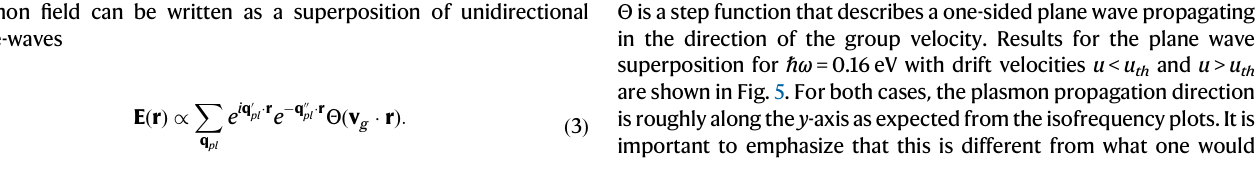
Fig. 4 | Isofrequency curves for the plasmon dispersion. a Isofrequency curves for u =0.AllotherparametersfortheDiracmodelareidenticaltoparametersused in Fig. 2. Color scale quanti fi es the quality factor q 0 = q 00 which gives the number of cycles the plasmon goes through before decaying or amplifying by e .